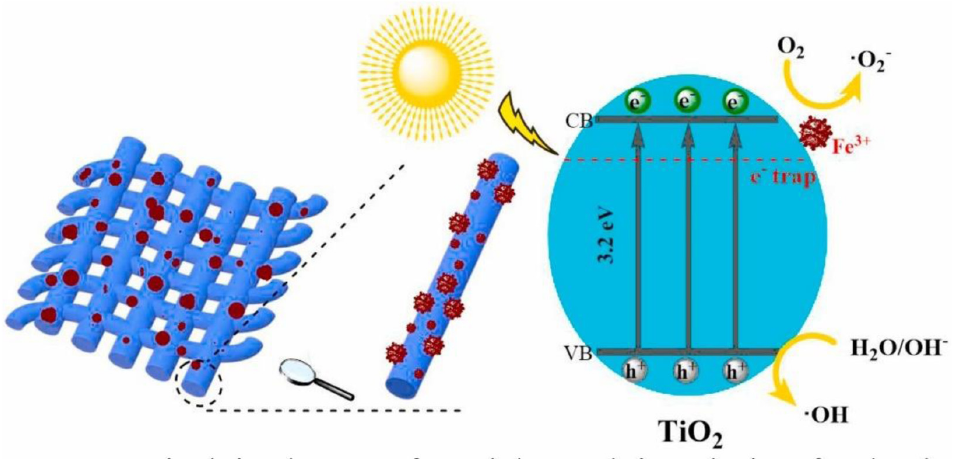
Figure 8. Simulated charge-transfer and photocatalysis mechanism for the Fe-doped TiO 2 photocatalyst. Reprinted/adapted with permission from Ref. [149]. 2021, Elsevier.